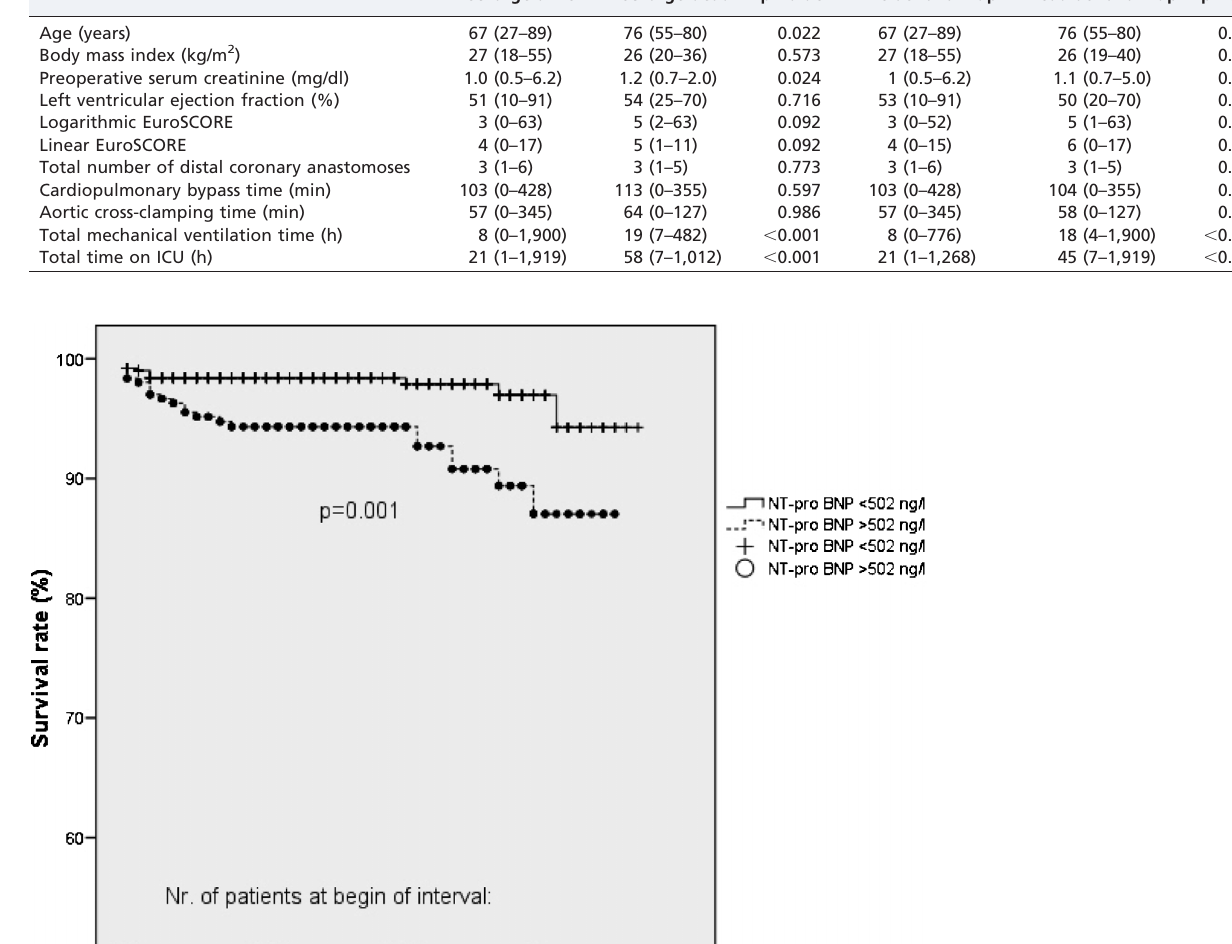
Table 2 - Statistical differences between patients who are alive or dead at discharge and at time of follow-up. Discharge alive Discharge dead p Value Alive at follow-up Dead at follow-up p Value